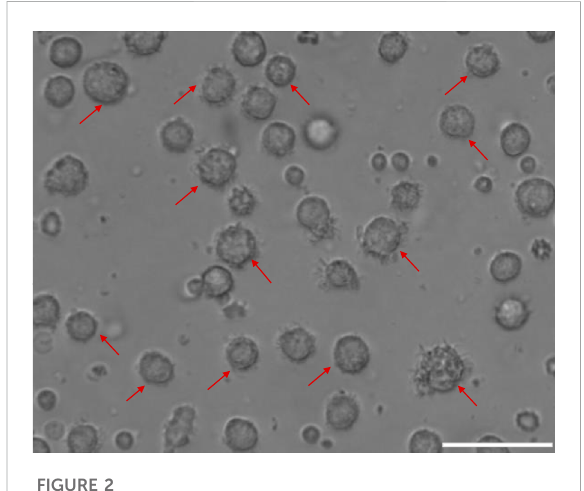
FIGURE 3 The comparison of the proportion of CD80 + CD86 + cells in total cells between the MM patient group and the HD group.